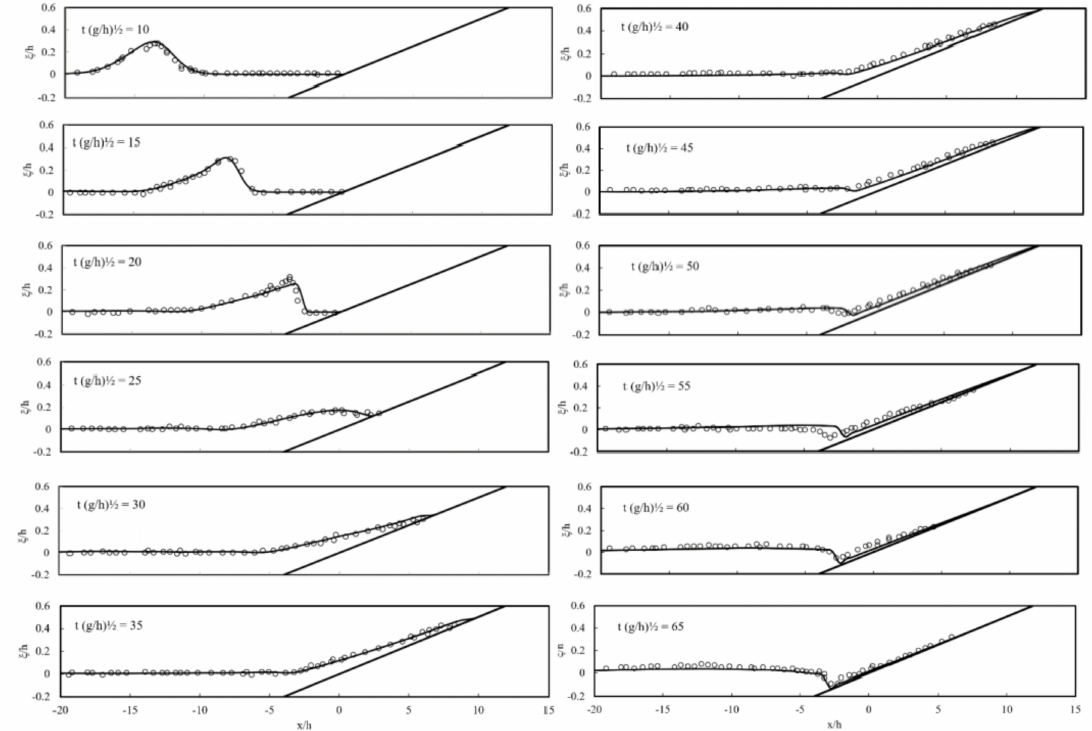
Figure 5. Comparison of simulated and measured surface profiles of a solitary wave runup on a 1:19.85 plane beach. Experimental data (circles), numerical results (solid